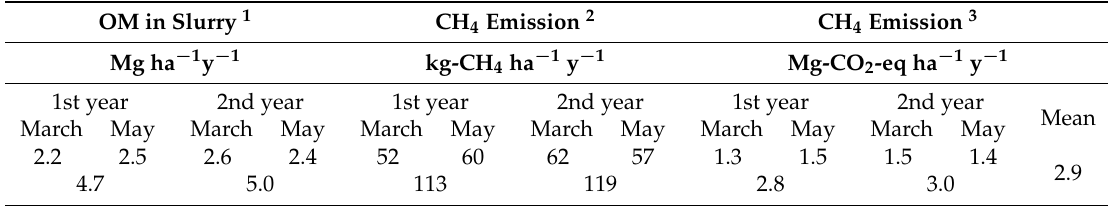
Table 1. Emission of CH 4 related to storage of dairy cattle slurry.